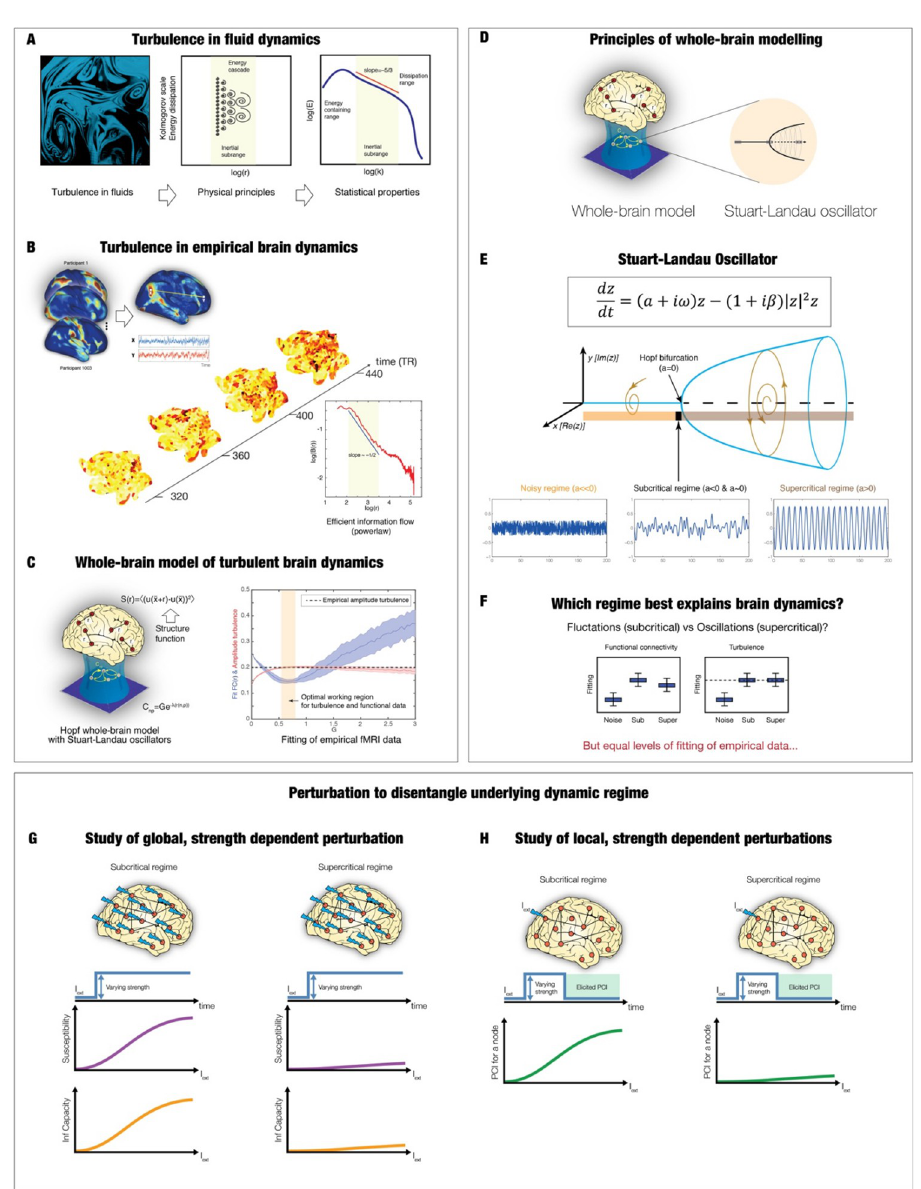
Fig 1. Overview of the framework. A) Turbulence provides a good description of the seemingly chaotic dynamics of fluids as first described by Leonardo da Vinci [9] (left panel drawing of turbulent whirls). The physical principles giving rise to turbulence are given by high-dimensional spacetime non-linear coupled systems. In turbulence, a fundamental property is its mixing capability which yields the energy cascade through turning large whirls into smaller whirls and eventually energy dissipation (middle panel). Furthermore, the turbulent energy cascade has been shown to be highly efficient across scales, as evidenced by a power law (right panel). B) Empirical brain dynamics was recently shown to exhibit turbulence [8]. The fMRI resting state analysis over 1000 healthy participants (left panel) shows the presence of highly variable, local synchronisation vortices across time and space (middle panel). Equally, the turbulent brain regime also gives rise to an efficient information cascade obeying a power law (right panel). C) Furthermore, Hopf whole-brain models [16] (left panel) were able to fit both turbulence and the empirical data at the same working point (right panel). D) We model brain activity as a system of non-linear Stuart Landau oscillators, coupled by known anatomical connectivity. E) The Stuart Landau equation (top panel) is suited for describing the transitions between noise and oscillation. By varying the local bifurcation parameter, a, the equation will produce three radically different regimes: Noise (a << 0), fluctuating subcritical regime (a < 0 & a~0) and oscillatory supercritical regime (a > 0) (bottom panel). F) We evaluated the fitting capacity of the three model regimes in terms of functional connectivity and turbulence (with the dashed line showing the empirical level of turbulence). G) However, it is well-known that physical systems can be more deeply probed by perturbing them. Therefore, we used strength-dependent perturbations